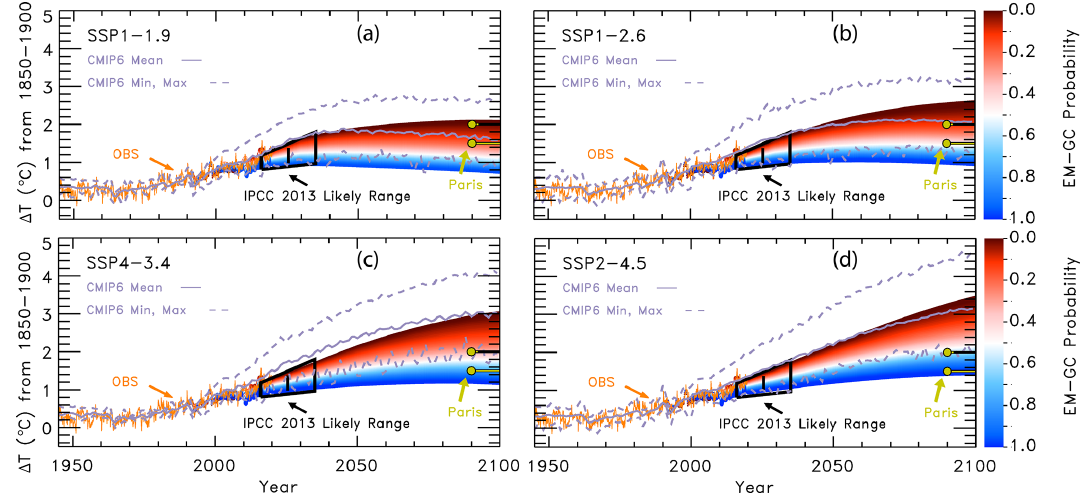
Figure 11. Probabilistic forecasts of the future rise in (cid:49)T from the EM-GC trained using the HadCRUT5 (cid:49)T record for several SSPs. (a) Future projections of (cid:49)T for SSP1-1.9. Observations (orange) are from HadCRUT5. The IPCC 2013 likely range of warming (black) is from Fig. 11.25b of Chapter 11 of IPCC 2013. The Paris Agreement target and upper limit (yellow) are shown for comparison to EM-GC projections. The CMIP6 minimum, multi-model mean, and maximum values of (cid:49)T are shown to compare to EM-GC projections. Colors denote the probability of reaching at least that temperature by the end of the century. (b) Future projections of (cid:49)T for SSP1-2.6. (c) Future projections of (cid:49)T for SSP4-3.4. (d) Future projections of (cid:49)T for SSP2-4.5.